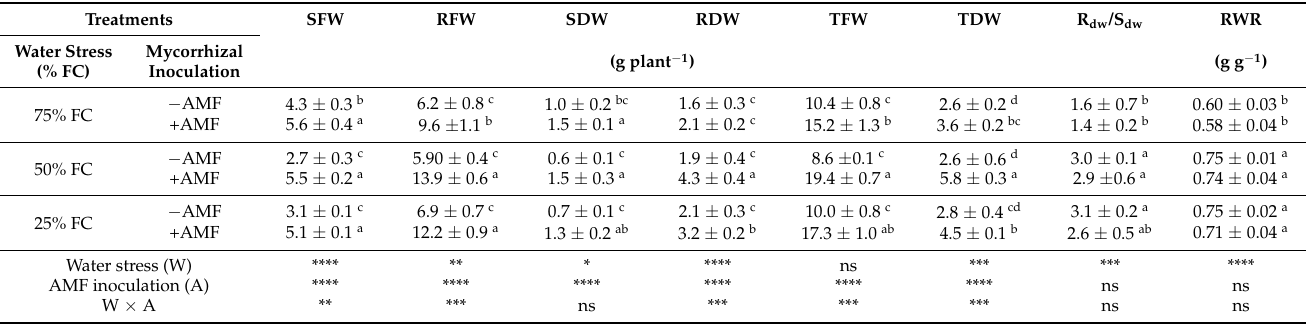
Table 2. Shoot fresh and dry weights (SFW and SDW), root fresh and dry weights (RFW and RDW), total fresh and dry biomass (TFW and TDW), root-shoot ratio (R dw /S dw ) and root weight ratio (RWR) of non-mycorrhizal ( − AMF) and (+AMF) mycorrhizal C. spinosa plantlets at three levels of water-deficit stress (%